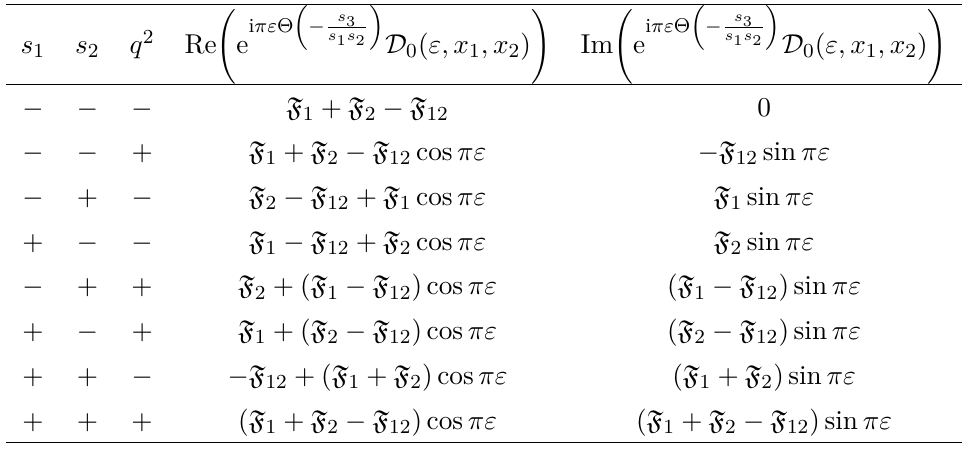
(cid:0) (cid:1) − s 3 D 0 ( ε, x 1 , x 2 ) in the areas specified by the signs s 1 s 2